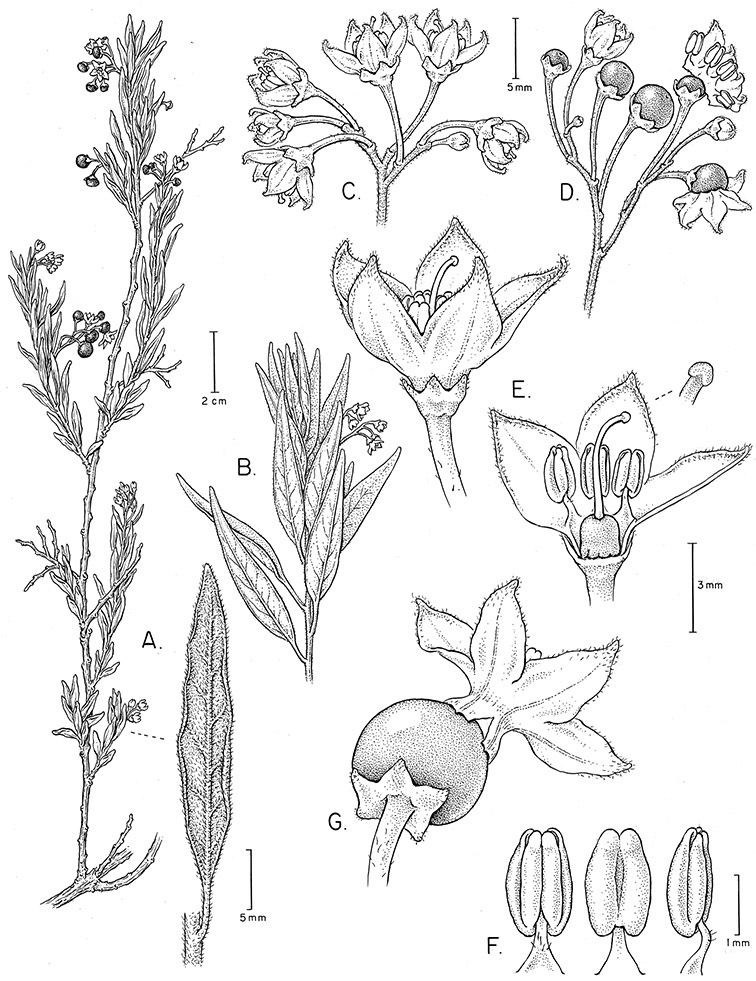
Solanum endoadenium Bitter. (A, C–G drawn from Hunziker et al. 25550
B
Legname & Vervoorst 154). Illustration by Bobbi Angell.